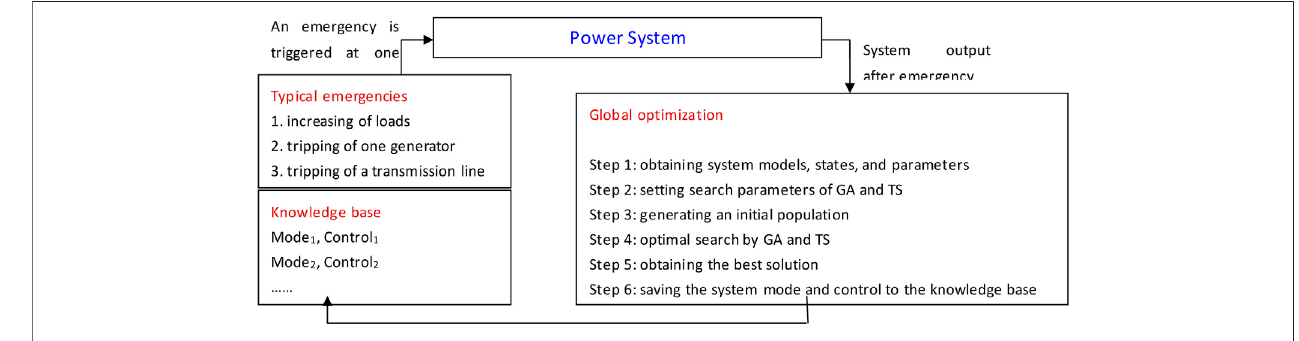
FIGURE 3 | Knowledge preparation.